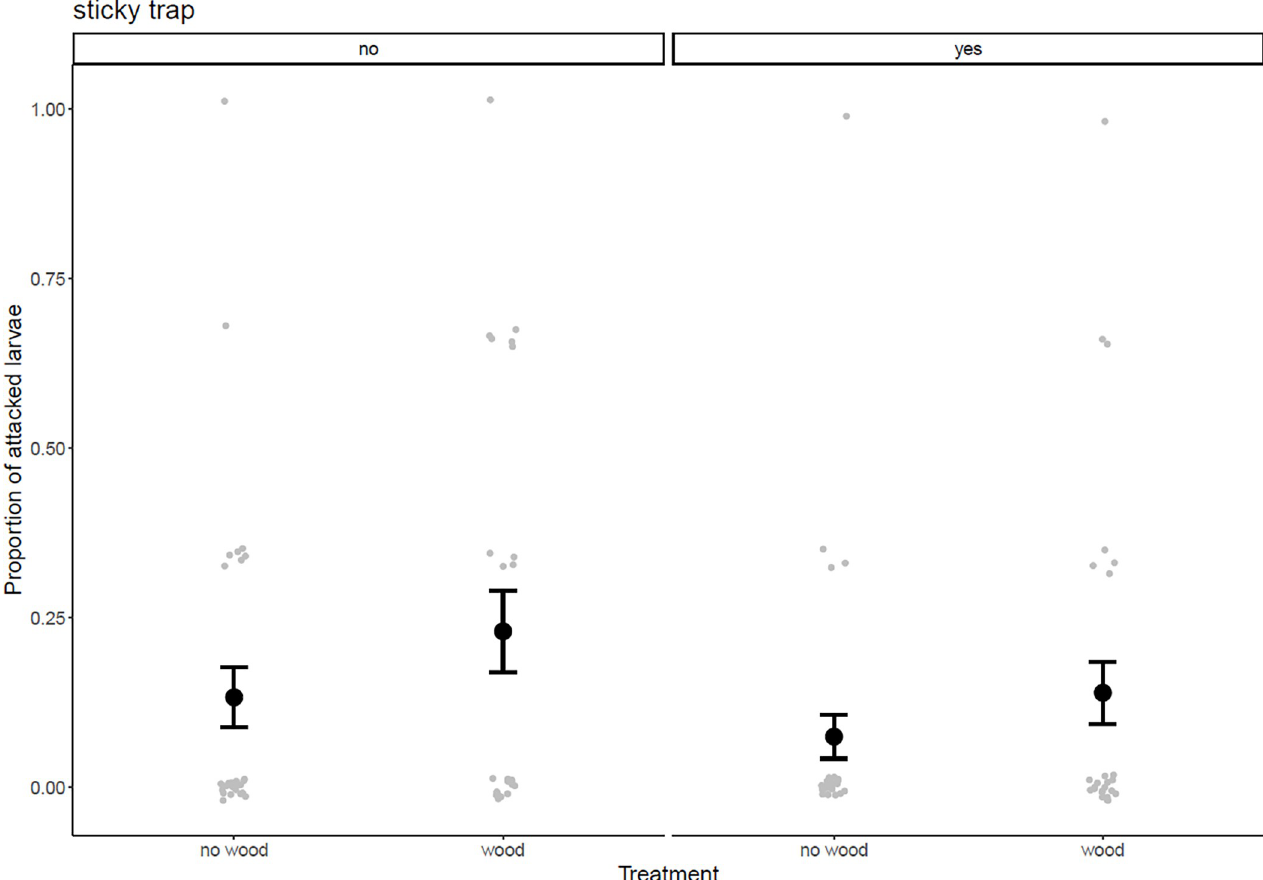
Fig 4. The proportion of attacked plasticine larvae on trees without and with sticky traps (no/yes) in relation to dead wood treatment; removed or added. Grey points represent the individual data points (i.e the proportion of attacked larvae per tree, 0, 1, 2, or 3 out of 3) and black points and error bars represent the mean value and standard error. Mean ± SE: 0.14 ± 0.05, 0.24 ± 0.07, 0.08 ± 0.04 and 0.15 ± 0.05, from left to